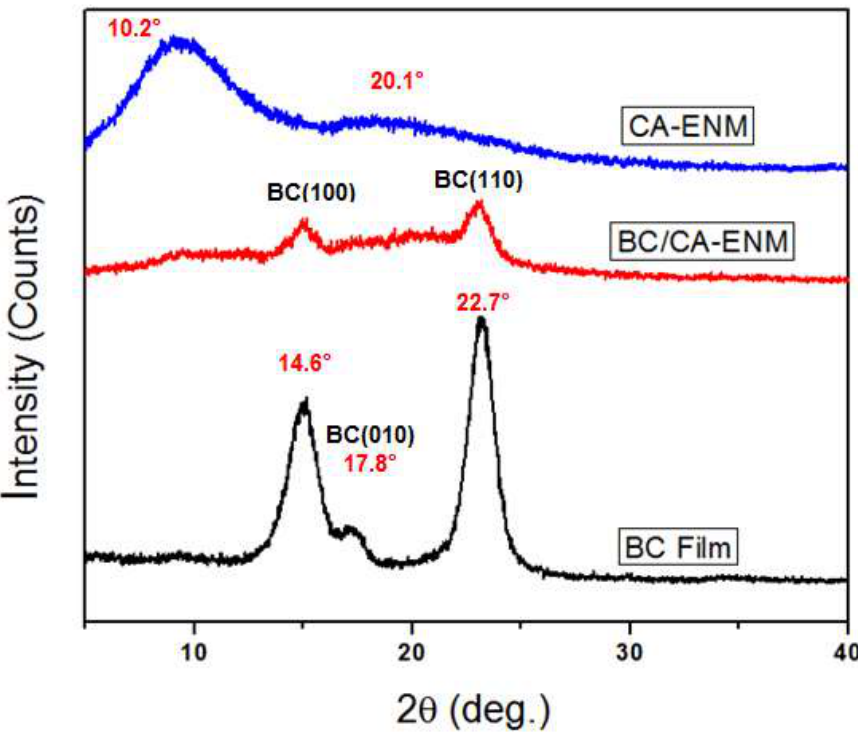
Figure 7. XRD diffractograms of BC films, CA-ENMs, and BC/CA-ENM hybrid mat samples.